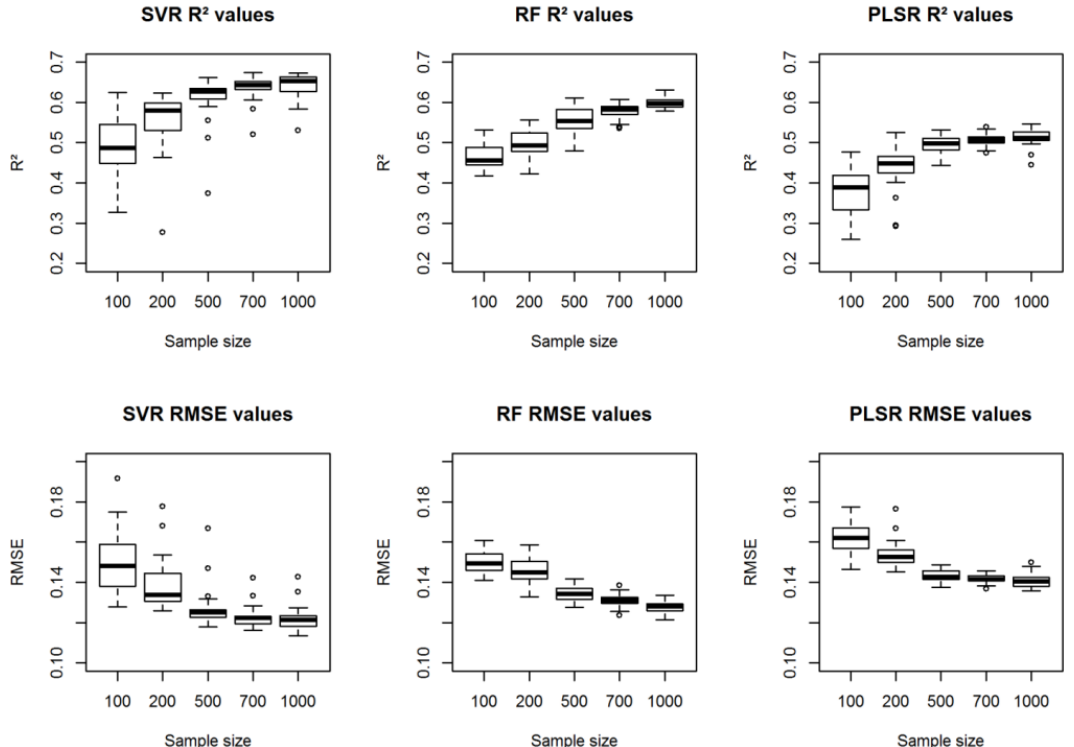
Figure 4. Boxplots of R 2 and RMSE values for all algorithms and sample sizes after 30